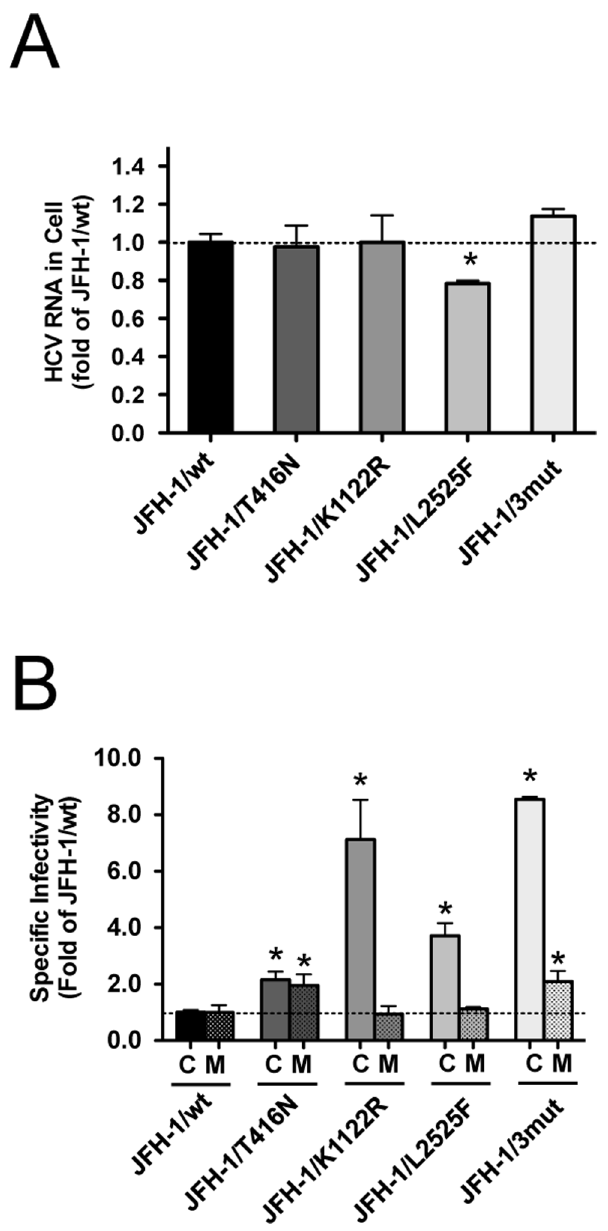
Figure 3. Single cycle virus production assay to assess contribution of mutations on viral life cycle. (A) Intra-cellular HCV RNA titers were assessed in full-length RNA of JFH-1/wt and its variants transfected into Huh7–25 cells. Data are given as fold change vs. JFH-1/wt. (B) Intra- and extra-cellular specific infectivity of JFH-1/wt and its variants transfected into Huh7–25 cells were calculated. Data are given as fold change vs. JFH-1/wt. C; intracellular specific infectivity, M; extracellular specific infectivity, * p , 0.05.